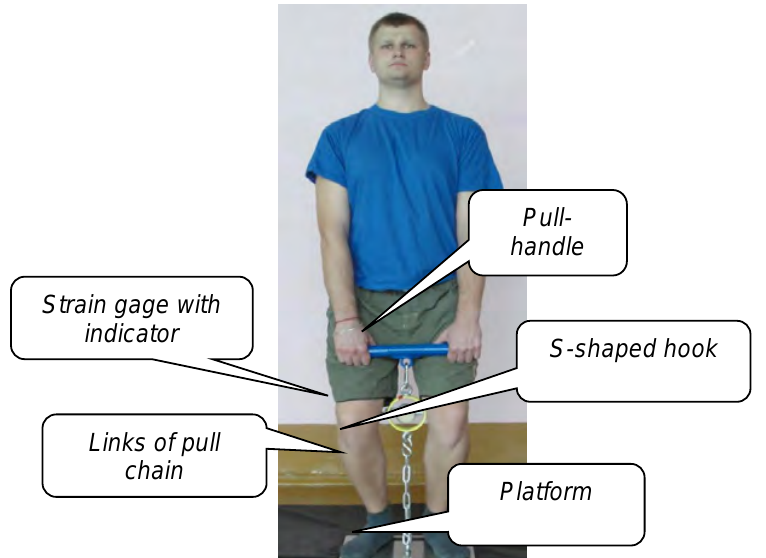
Fig.1. General view of dynamometric device for determination of dead-lift power and pulling force of legs’ extensors, of foot